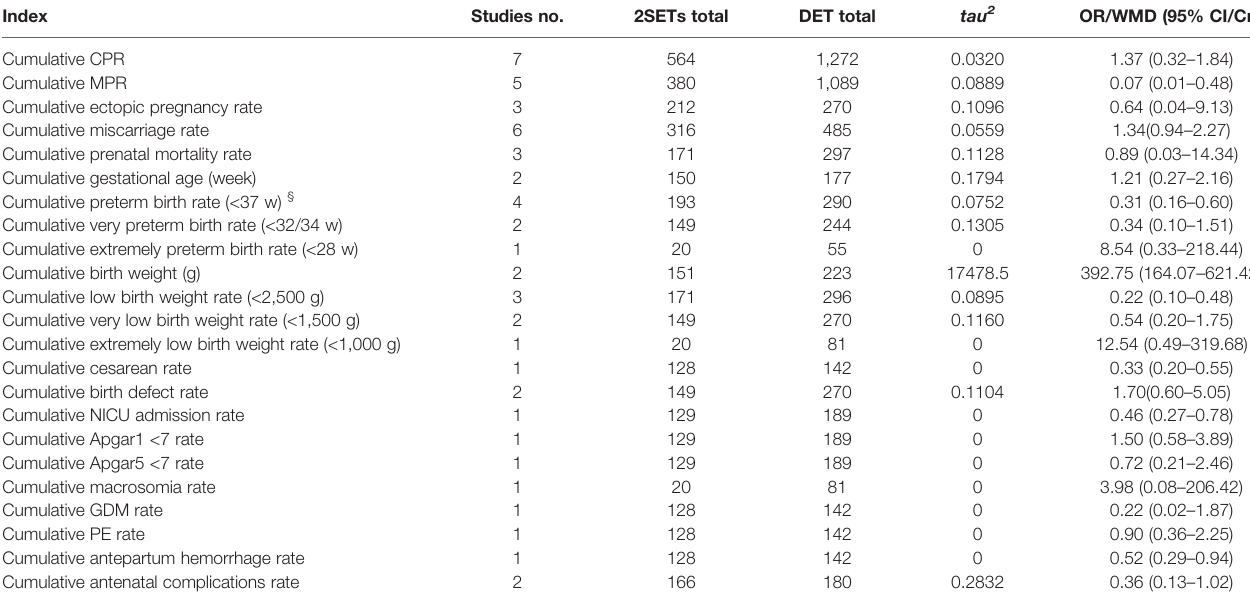
TABLE 3 | Fertility and maternal and neonatal outcomes of two consecutive cycles of two consecutive cycles of SET(2SETs) and one cycle of DET. Index Studies